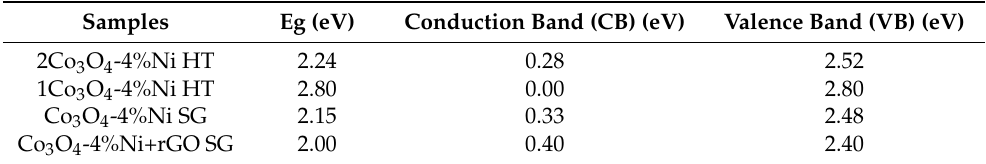
Table 1. The conduction band (CB) and valence band (VB) calculated according to the Mulliken